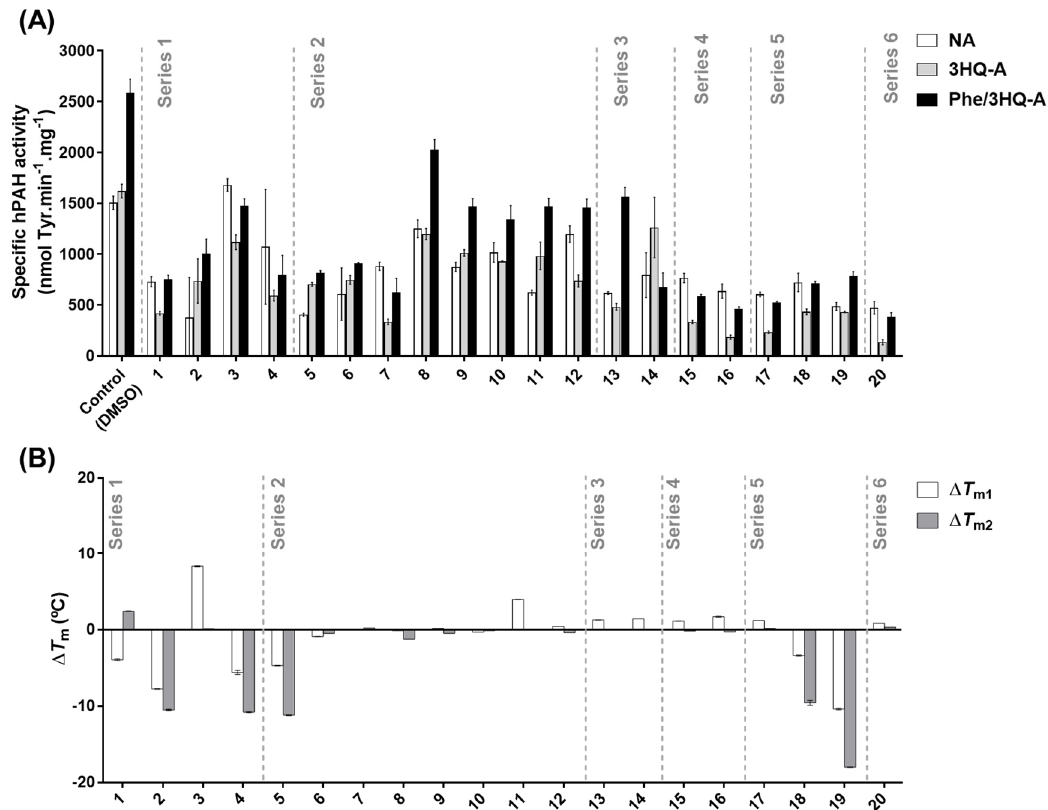
Figure 3. Effect of the 3-hydroxyquinolin-2(1H)-one (3HQ) derivatives library on the specific enzyme activity and thermal stability of human phenylalanine hydroxylase (hPAH). ( A ) Catalytic activity was determined in three different conditions: Non-activated (NA) where the substrate and tested 3HQs were added together with the cofactor at the start of the enzymatic reaction without pre-activation; 3HQ-activated (3HQ-A), where the enzyme was pre-incubated with the tested compound for 4 min at 25 °C and the reaction was started by the simultaneous addition of the substrate and cofactor; 3HQ/Substrate-activated (Phe/3HQ-A), where the enzyme was pre-incubated simultaneously with the substrate and the tested compound (4 min, 25 °C). ( B ) The mid-point of thermal denaturation ( T m ) for the regulatory ( T m1 ) and catalytic ( T m2 ) hPAH domains were determined by differential scanning fluorimetry and the values were compared to the control to calculate Δ T m . In A) and B) 3HQs were tested at 100 μ M in 1% DMSO (V) and data were compared to the control assays (1% DMSO and absence of 3HQ); data represent the mean ± SD from three independent assays.